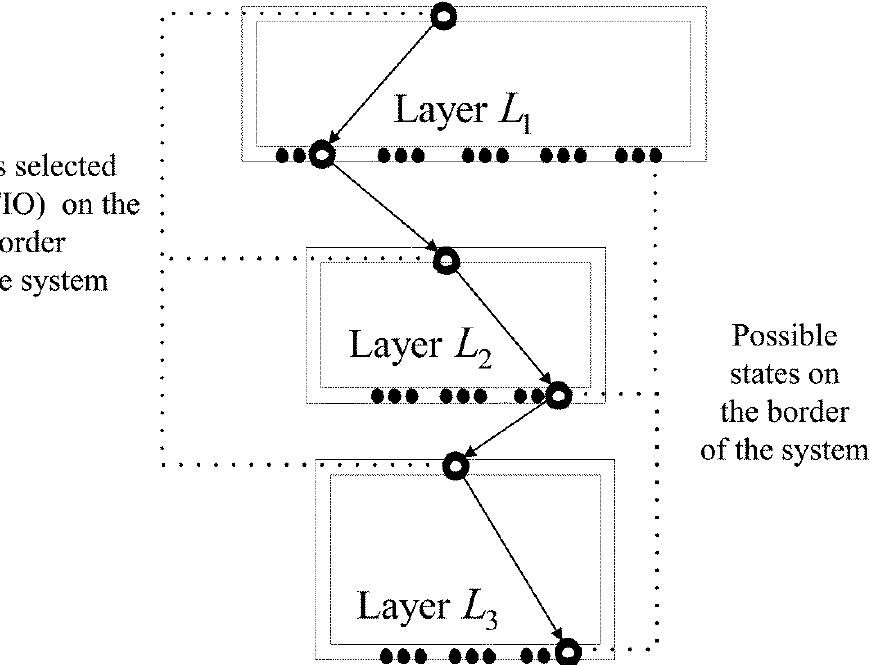
Figure 2. Sequences of selected states on the border of the system (shown by small empty circles), possible states on the border of the system (shown by filled small circles) in the layers L 1 , L 2 , L 3 of the system functioning.